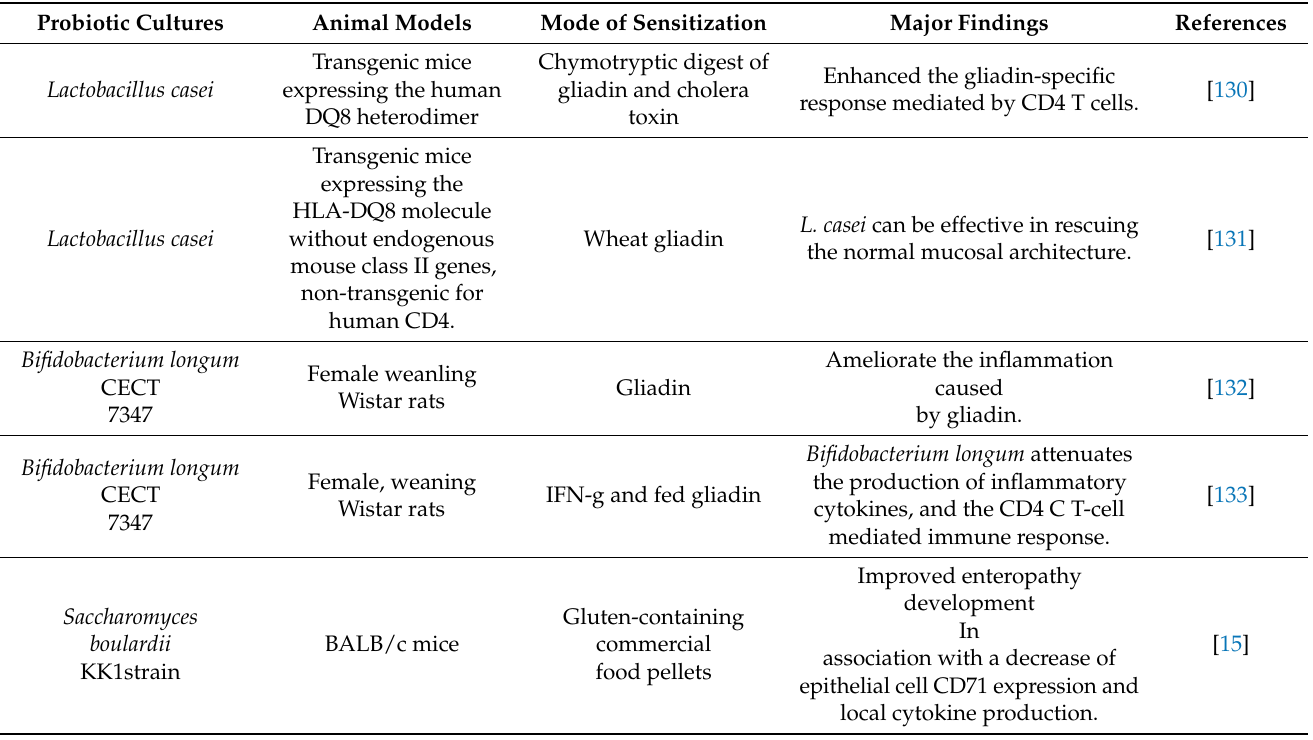
Table 2. Selected examples of animal